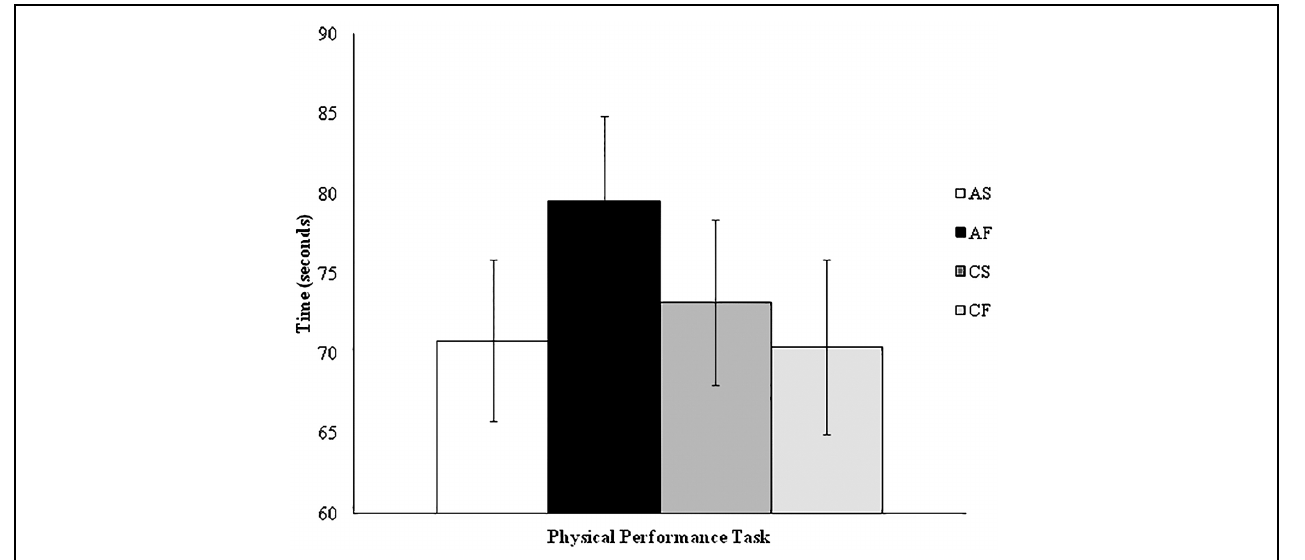
FIGURE 3 | Physical performance task time by experimental condition. AS, autonomous success; AF, autonomous failure; CS, controlled success; CF, controlled failure.